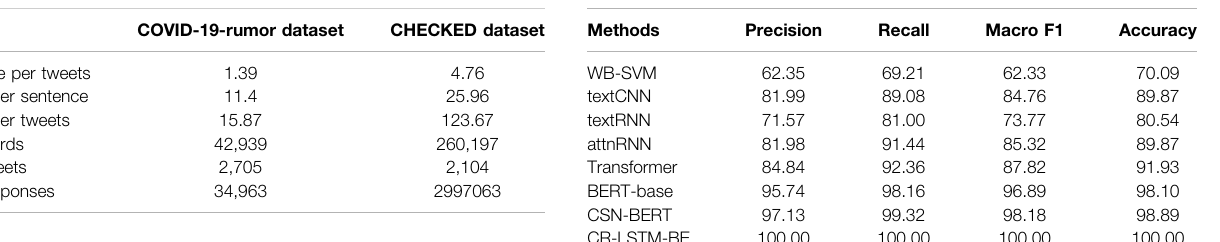
TABLE 1 | Statistics of the datasets.